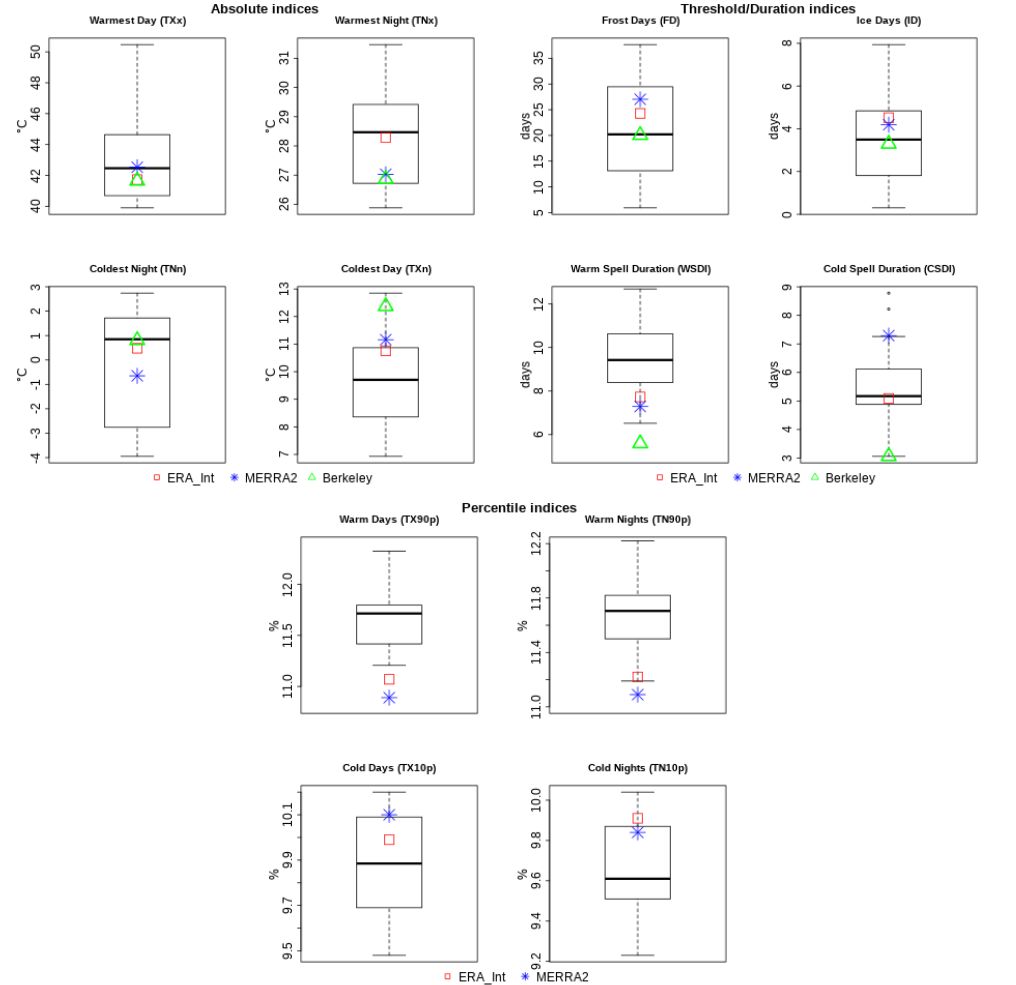
Figure 11. Box-and-whisker plots of the temperature indices of extremes climatology calculated from the CMIP5 (RCP4.5) 18-model MENA domain averages for 1980–2018. The boxes indicate the inter-quartile range (IQR, between the 25th and 75th percentiles), the bold horizontal bar in the middle of the box is the median and the whiskers indicate the maximum and minimum values from the multi-model sample. The different symbols represent the corresponding climatology for ERA-Interim (red), MERRA-2 (blue) and Berkeley Earth (green). Arranged as absolute ( top left ), threshold/duration ( top right ) and percentile ( bottom )